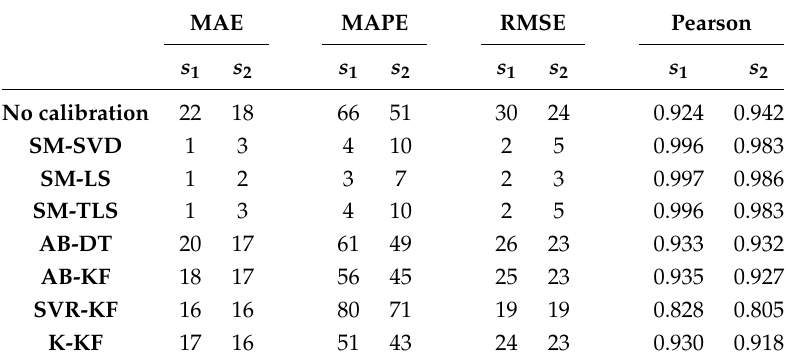
Table 2. Values of the metrics, computed on the entire time interval of drift, for two particular sensors of the network s 1 = 2 and s 2 = 10. Strategies AB-(DT, KF) and (SVR, K)-KF are quite equivalent for these two instruments. The improvements are rather small for both sensors. For SM-(SVD, LS, TLS), results are consistent with the observations of Table